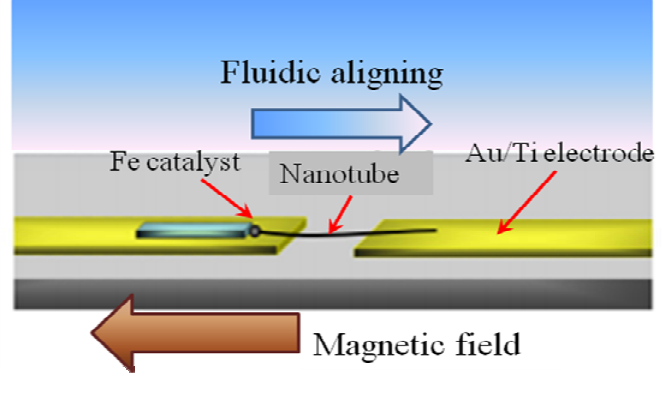
Figure 11. The carbon nanotube (CNT) is aligned parallel to the fl ow direction (Reprinted with permission from [95]. Copyright 2009 Institute of